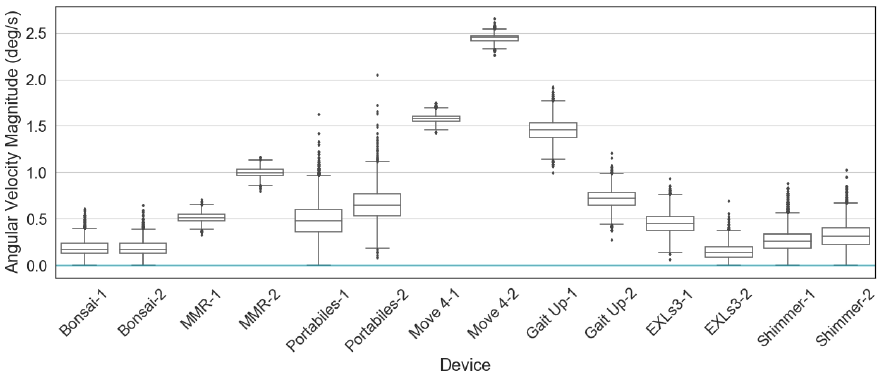
Figure 6. Gyroscope baselines. Angular velocity at 0 deg/s marked by a turquoise line.